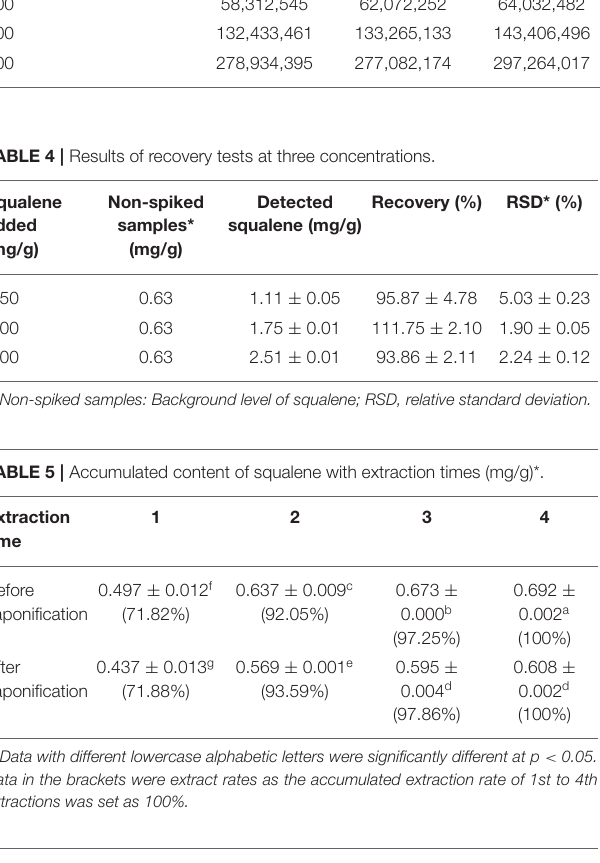
TABLE 6 | Changes in squalene content with maturity of leaf*. Leaf position on shoots